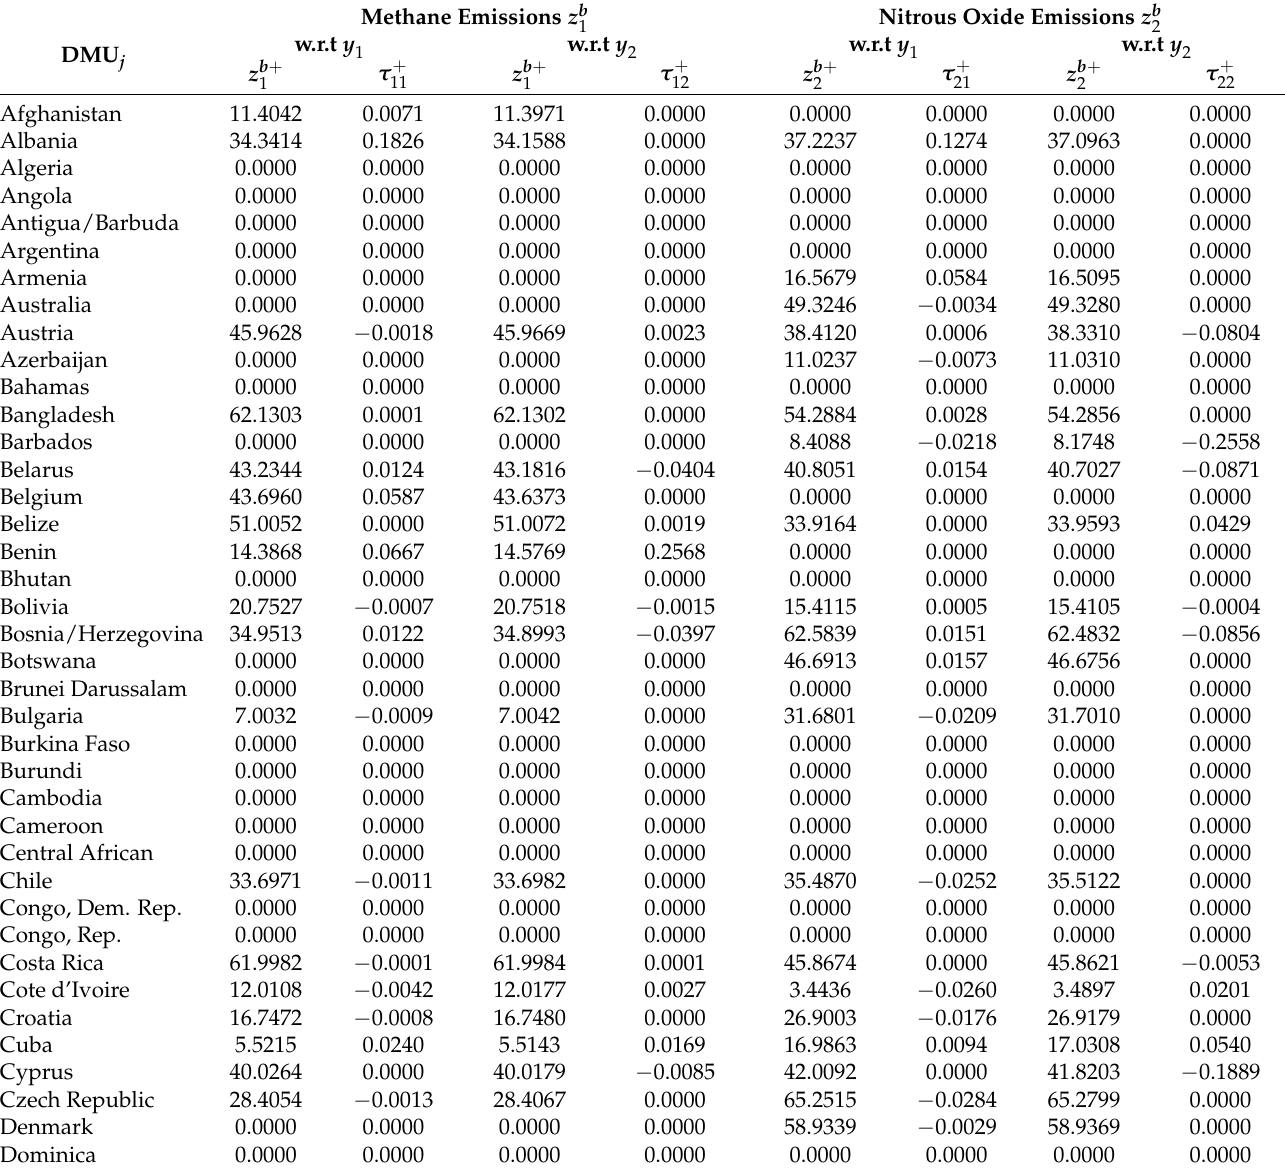
) and nitrous oxide ( z b 1